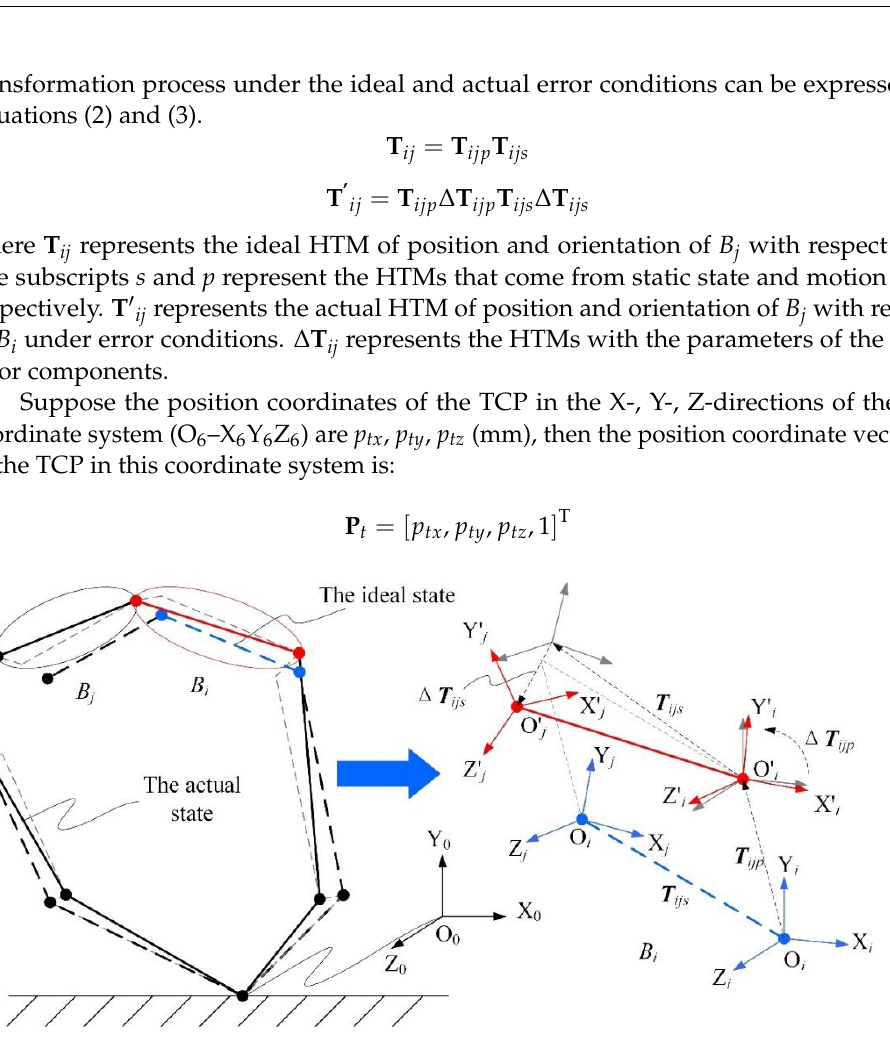
Figure 4. Geometric features of kinematic with error existing between part Bi and Bj.